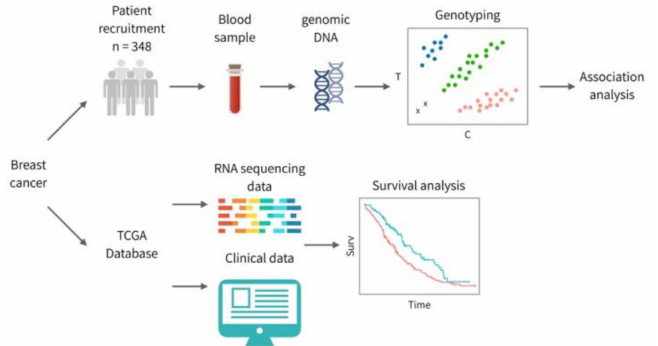
Figure 1. An overview of the study design; 348 BC patients were recruited in this study, and genomic DNA was extracted from peripheral blood samples. Four tagging single nucleotide variants (SNVs) were selected for genotyping and further examined for germline association of the stromal interaction molecule 1 (STIM1) gene. RNA-seq data and clinical data of BC were downloaded from The Cancer Genome Atlas (TCGA) database to conduct survival